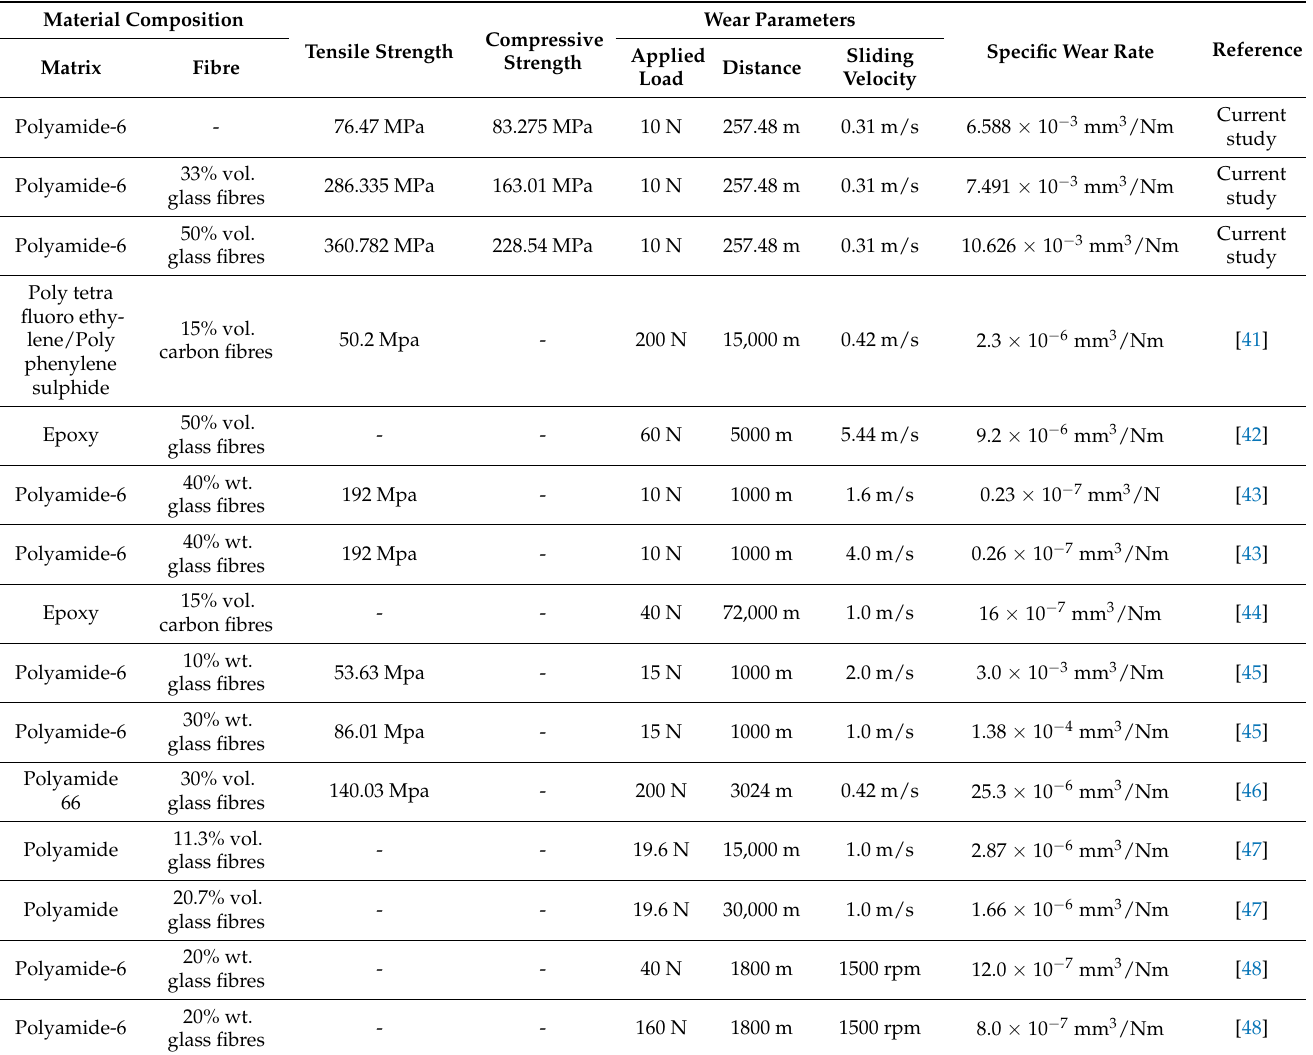
Table 7. Comparative analysis between the results of the current study and the relevant studies from the literature